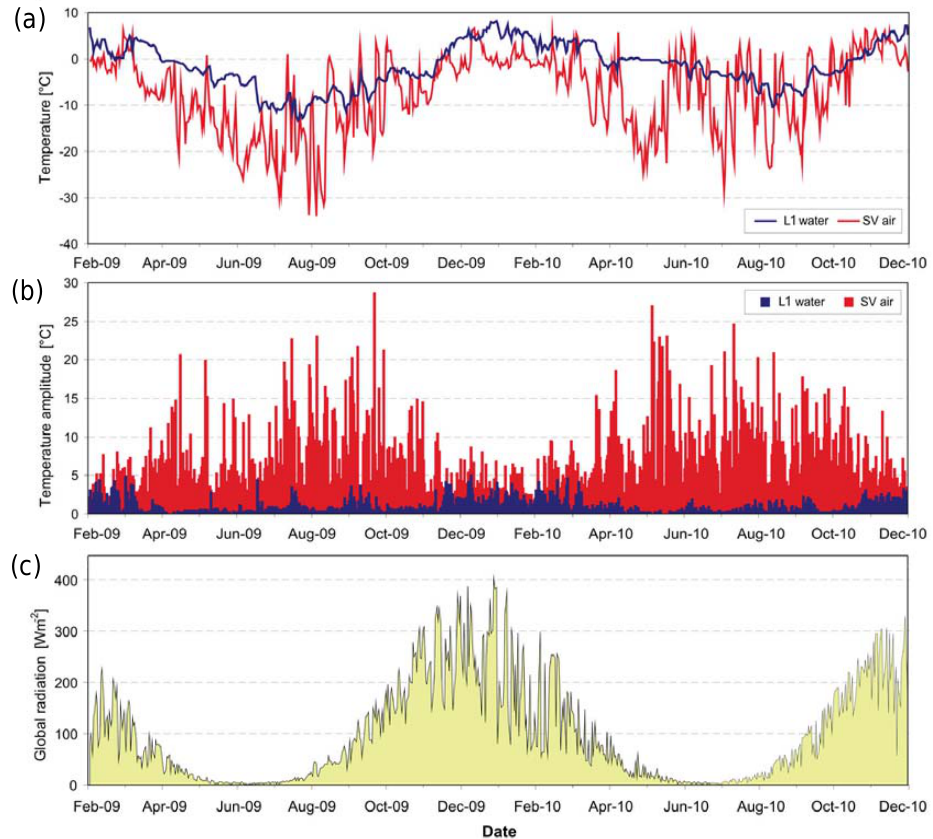
Figure 3. (a) Annual variation of daily mean water temperature in lake 1 (L1 water) and annual variation of daily mean air temperature in the Solorina Valley (SV air), (b) diurnal temperature amplitudes in lake 1 (L1 water) and diurnal air temperature amplitudes in the Solorina Valley (SV air), respectively. (c) Daily mean global radiation at Mendel Station. All parameters were measured from February 2009 to November